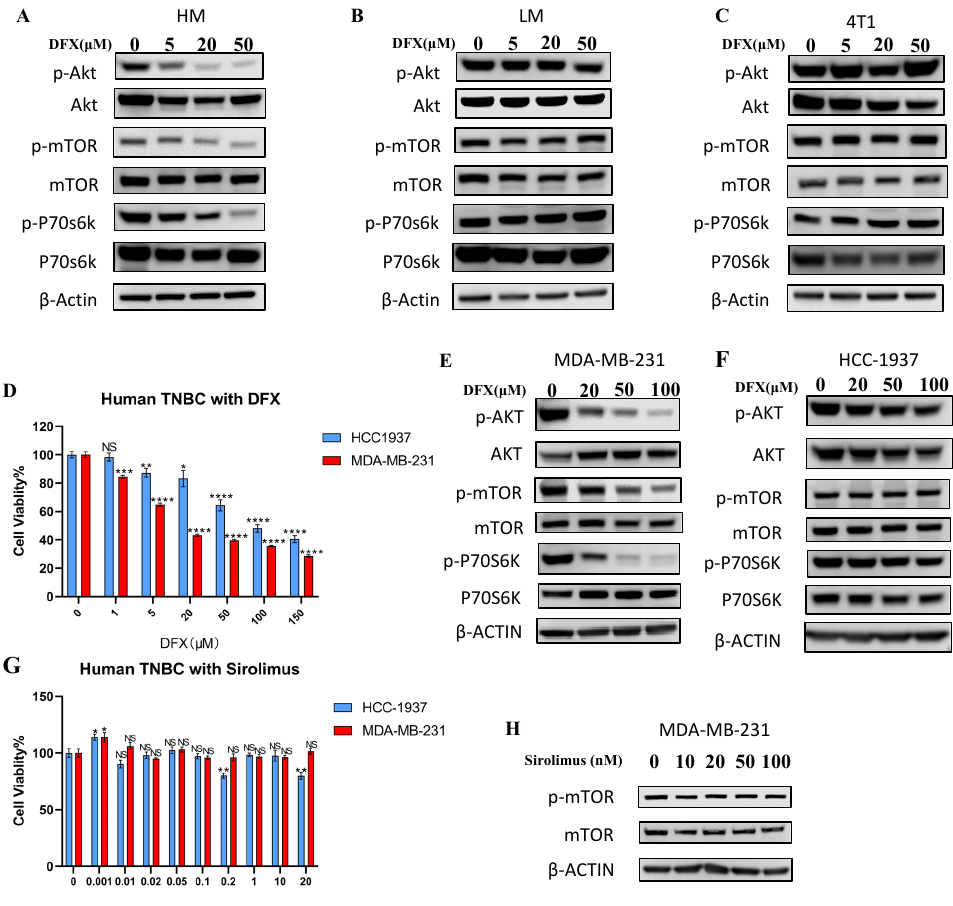
Figure 5. DFX inhibits the AKT/mTOR signaling pathway. ( A – C ) 4T1–HM, 4T1–LM, and 4T1 parent cells were treated for 48 h with DFX or with equivalent DMSO alone, followed by the collection of whole cell lysis buffer. The protein expression level was detected by western blot. β –actin was used as an internal control. ( D ) Human TNBC cells, MDA–MB–231, and HCC–1937, were similarly treated for 48 h with DFX ( n = 6). Cell viability was determined via Cell Proliferation Kit II (XTT). Treatment groups were compared with Control group, respectively. The Student’s t test with Welch’s correction was utilized to compare two groups, p ** < 0.01, p *** < 0.001, and p **** < 0.0001, and Data shown as the mean ± S. E. M. ( E , F ) MDA–MB–231 and HCC–1937 were treated for 48 h with DFX or with equivalent DMSO alone, followed by the collection of whole cell lysis buffer. The protein expression levels were detected by western blot. ( G ) Human TNBC MDA–MB–231 and HCC–1937 were treated for 48 h with sirolimus in different concentration or with equivalent saline or DMSO alone ( n = 6). Cell viability was determined via Cell Proliferation Kit II (XTT). Treatment groups were compared with Control group, respectively. The Student’s t test with Welch’s correc- tion was utilized to compare two groups, NS represented not significant, p * < 0.05 and p ** < 0.01, and Data shown as the mean ± S. E. M. ( H ) Human TNBC MDA–MB–231 were treated for 48 h with varying concentrations of sirolimus, followed by the collection of whole cell lysis buffer after 48 h.